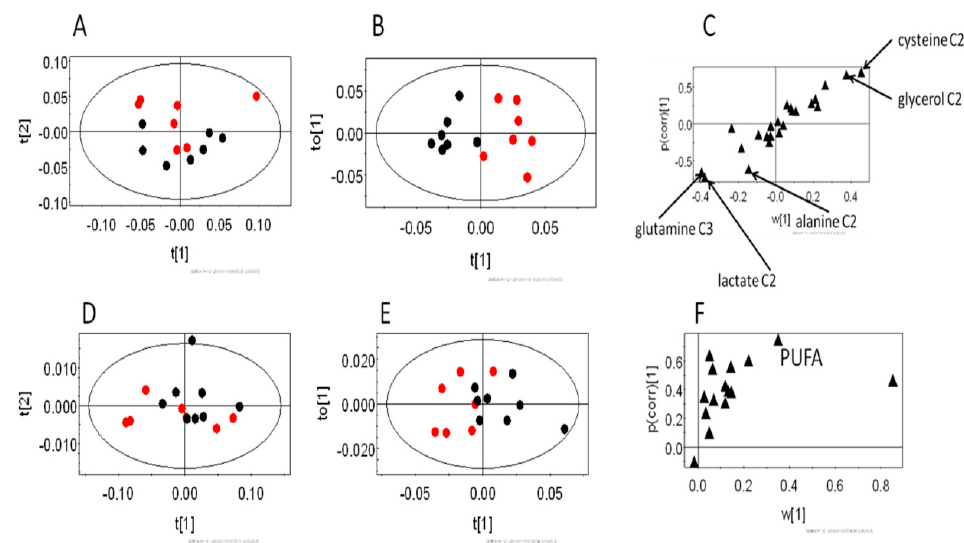
Figure 3. The changes in the labeling patterns from (2 13 C) glucose in the livers of early stage infection (~1% parasitemia) and uninfected control mice. ( A – C ) hydrophilic extract and ( D – F ) hydrophobic extract of the liver. ( A , C ) PCA scores plot and ( B , E ) OPLSDA score plots of the corresponding models; black—early stage, and red—control animals. ( C , F ) relevant OPLSDA loadings plots. PUFA: polyunsaturated fatty acids. The assignments of significant loadings are tabulated in Supplementary Table S1.